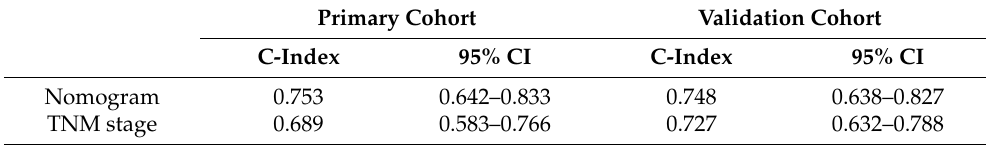
Table 4. Overall survival time (OS) in the primary cohort and validation cohort.